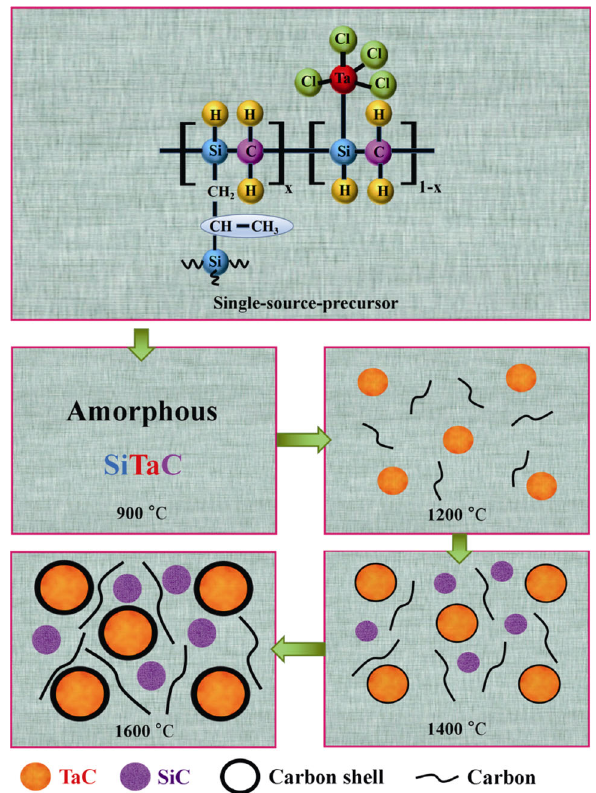
Fig. 7 Schematic illustration of phase evolution of SiC– TaC–C